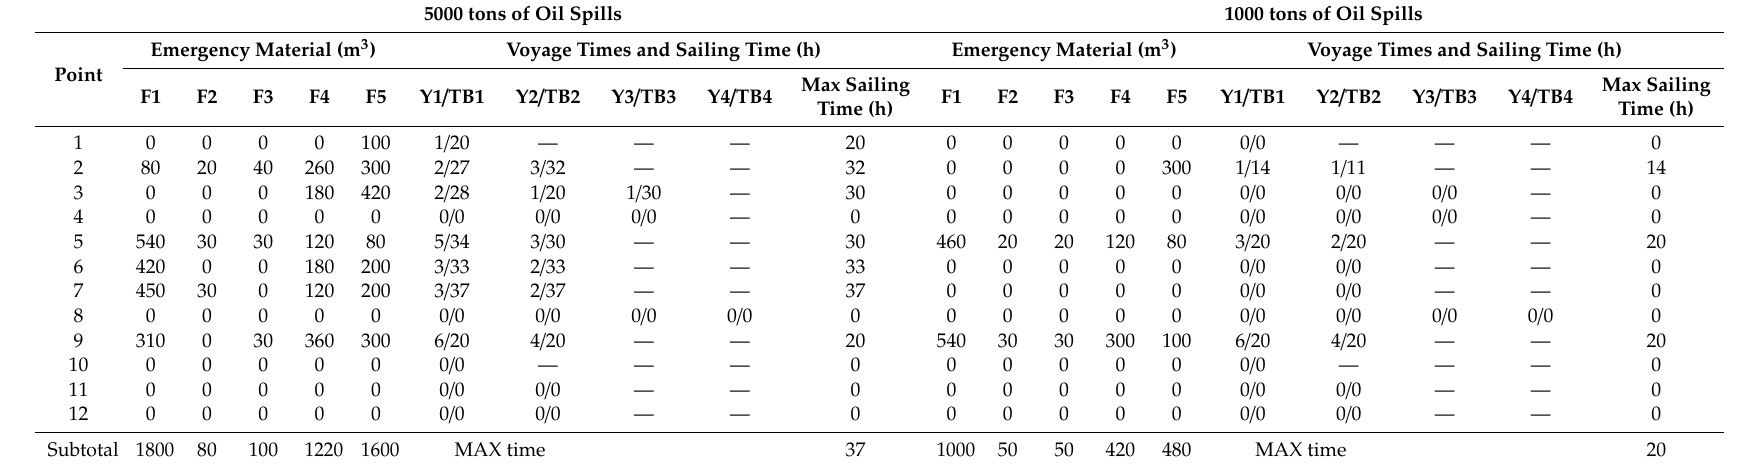
Table 4. Optimized dispatching schemes of emergency materials for 5000 tons and 1000